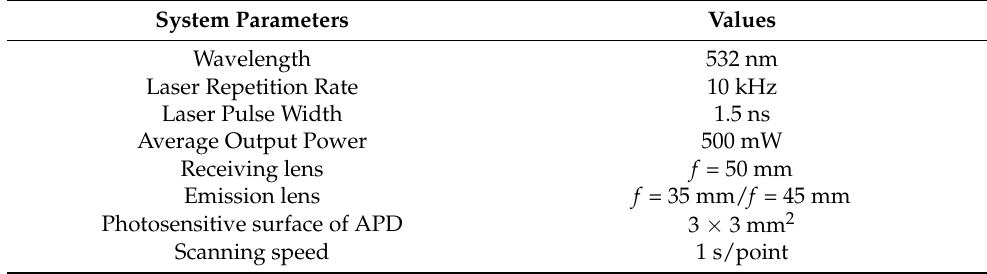
Figure 8. The experimental setup of 3D laser imaging system. Table 1. Summary of the system parameters.